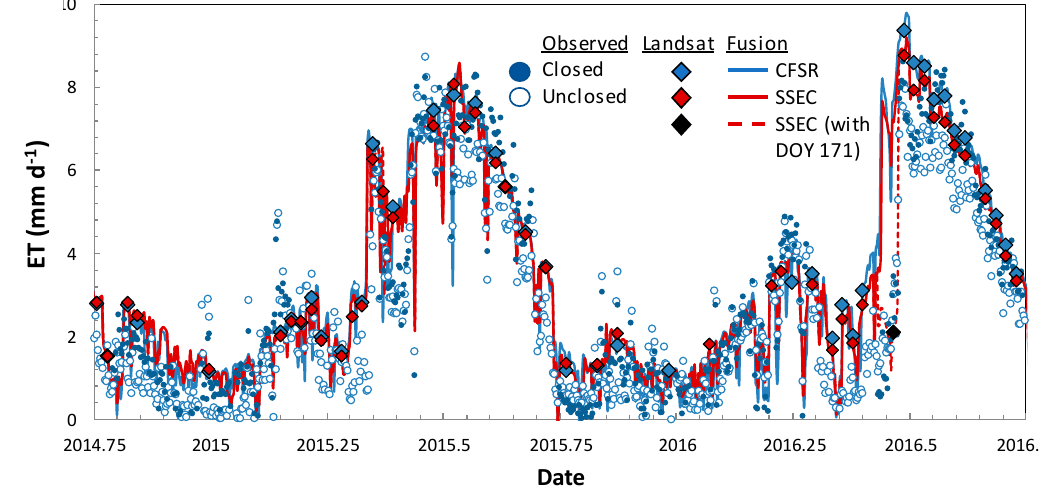
Figure 10. Timeseries of daily ET observations (unclosed and closed circles) at US-Twt and retrievals using the CFSR (light blue) and SSEC (red) insolation inputs (diamonds: on Landsat dates, solid lines: fused timeseries). The fused timeseries generated using the Landsat retrieval on DOY 171 (black diamond) is also shown (red dotted line).